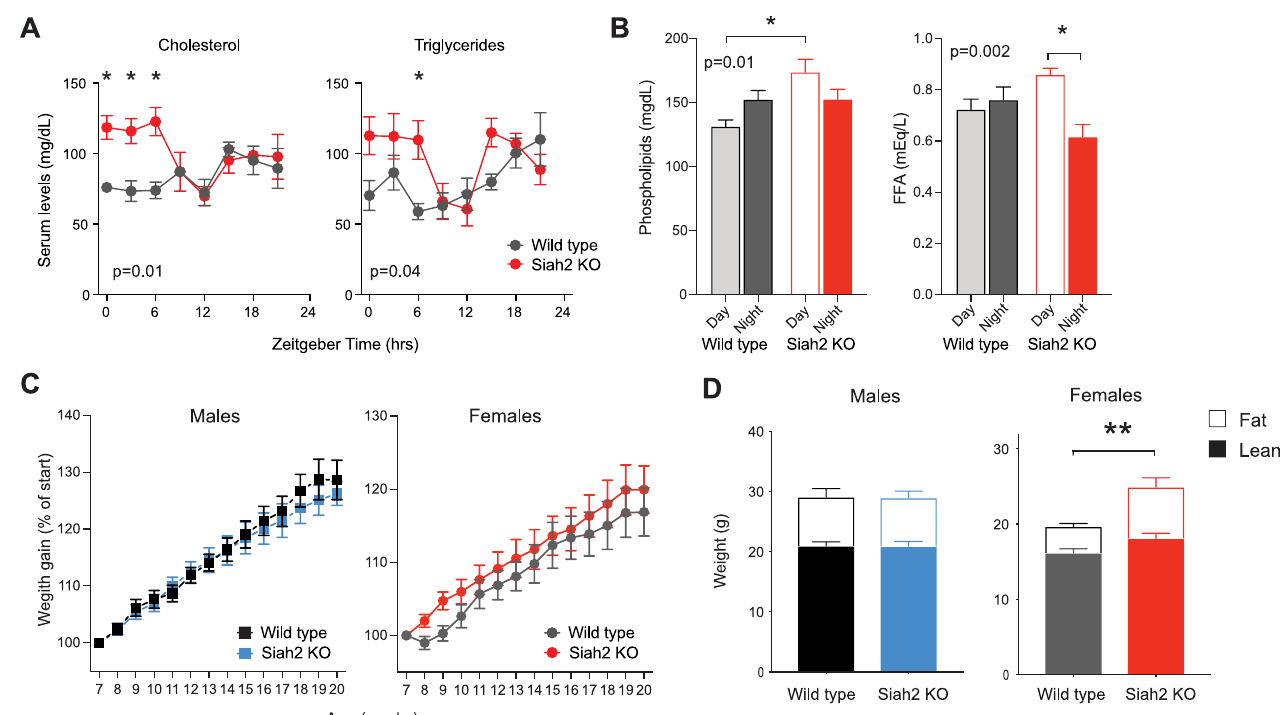
Fig 5. SIAH2 loss alters lipoprotein and lipid metabolism in females. ( A-B ) Serum lipid levels across the day in female mice fed normal chow ad libitum . In A, each point is the mean +/- SEM (n = 3 mice, except ZT 9, n = 4). In B, times 0–9 levels were averaged for day (+/- SEM, n = 13 each), times 12–21 averaged for night (+/- SEM, n = 12 each). The p-values shown denote significant genotype x time interactions from two-way ANOVA. � = p < 0.05 between genotypes (A) or times of day (B) using Sidak’s multiple comparison test. ( C ). Weight gain in mice fed control diet (CD) Mean +/- SEM, n = 8–10. ( D ) Body composition analysis. Mean +/- sem, n = 4–5 mice/sex and genotype. Loss of SIAH2 significantly increased adiposity in females on control diet for 13 weeks ( �� = p = 0.0247, two-tailed t-test).